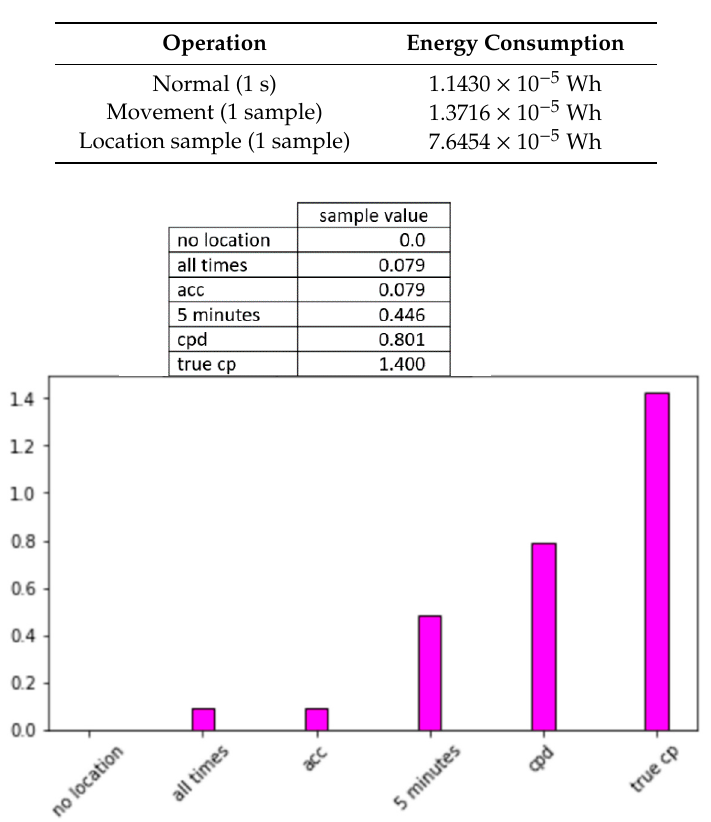
Table5. Energyconsumptionpersecondbynormalwatchoperations, movementsampling, andlocation sampling.